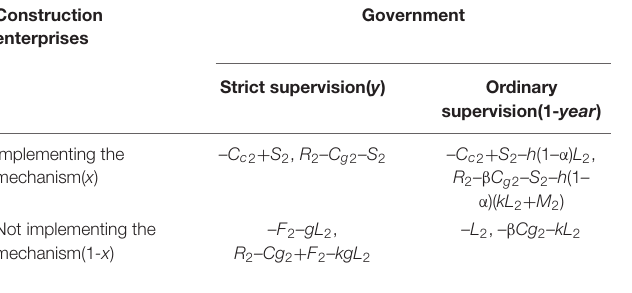
TABLE 3 | The benefit matrix between government and construction enterprises. Construction